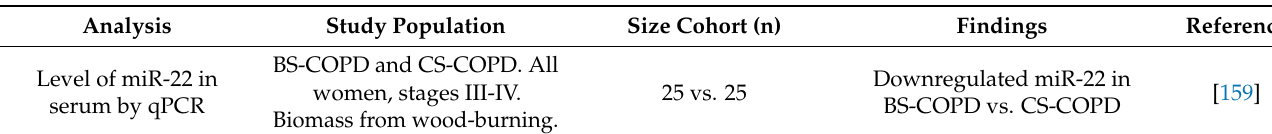
Table 5. Studies of miRNAs in biomass smoke-related COPD (BS-COPD) compared to cigarette smoke-related COPD